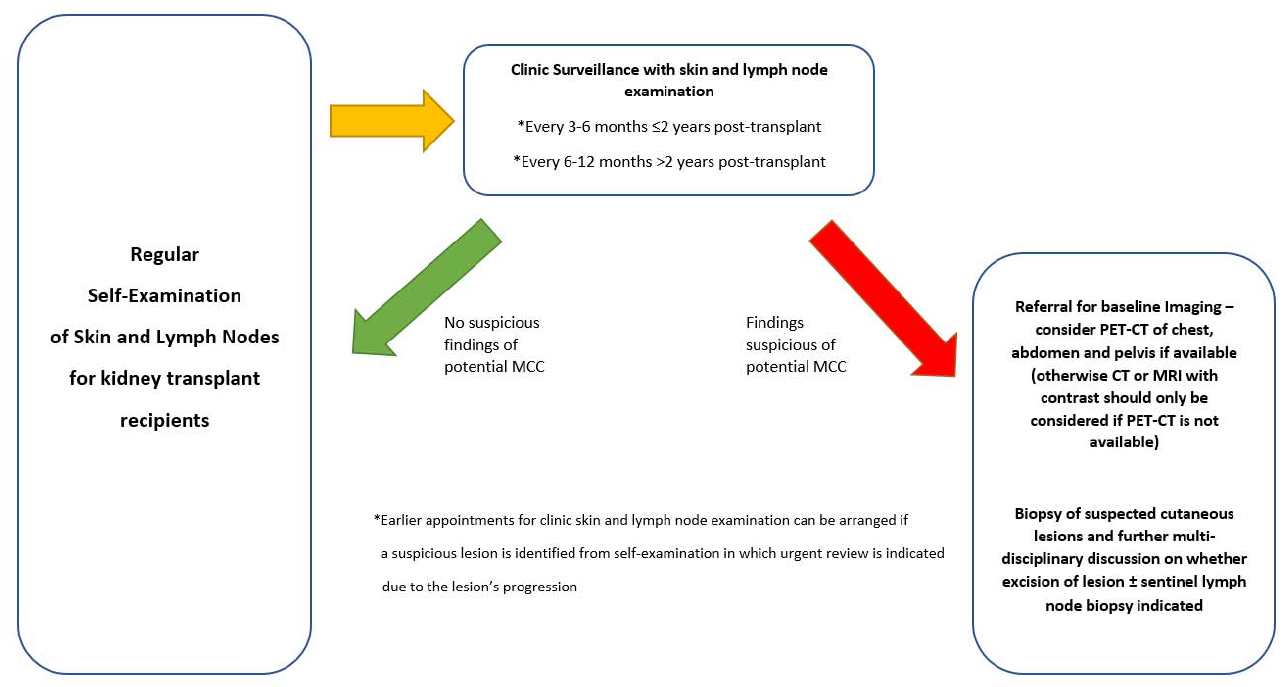
Figure 4. Simplified strategy for screening and diagnosis of MCC in Kidney Transplant Recipients.